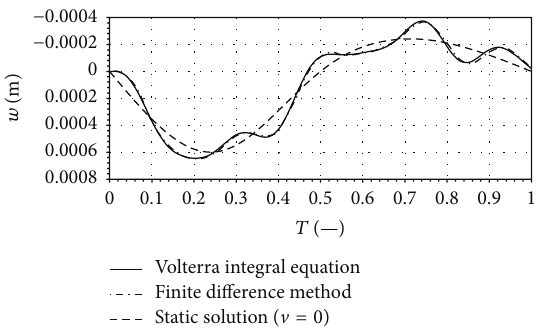
Figure 11: Dynamic deflection of point “a” (middle of the first span) due to a moving force.